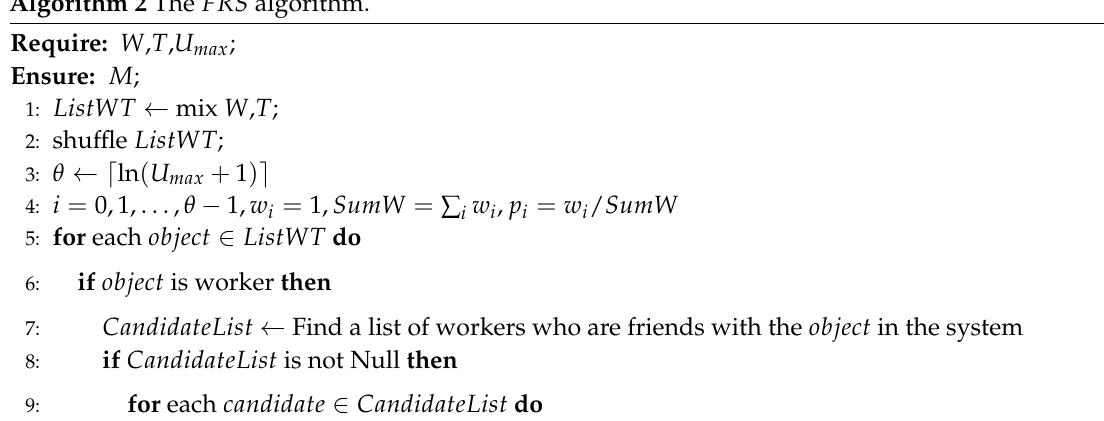
Algorithm 2 The FRS